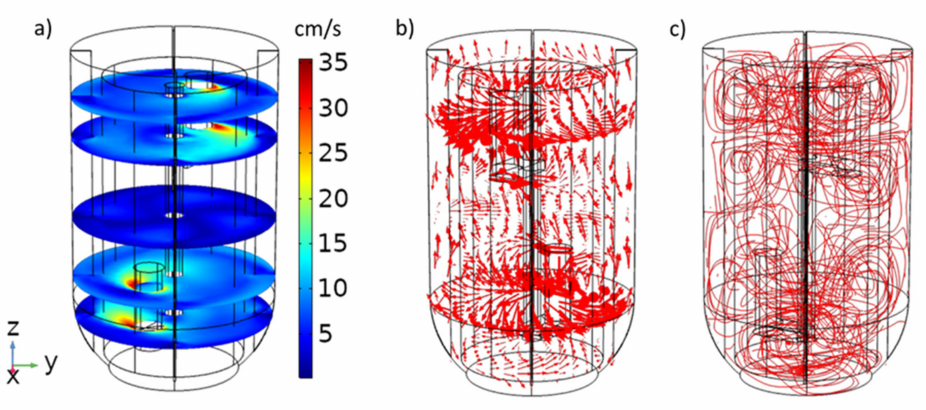
Figure 6. Hydrodynamic variables in the adsorber at 100 rpm: ( a ) velocity profiles (cm/s) in x–y planes, ( b ) proportional local velocity vectors, ( c )